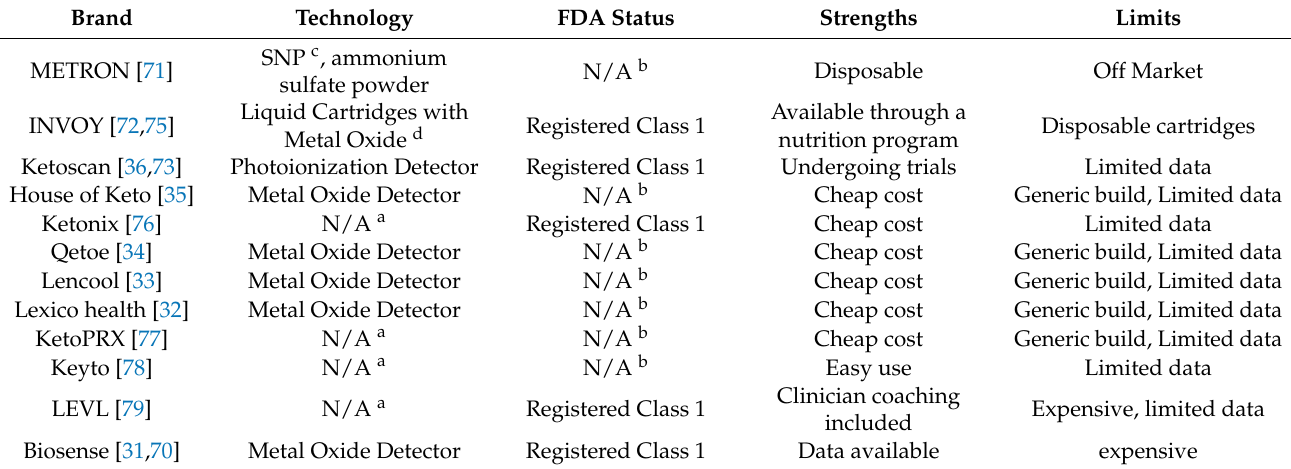
Table 1. Current commercially available breath acetone sensing